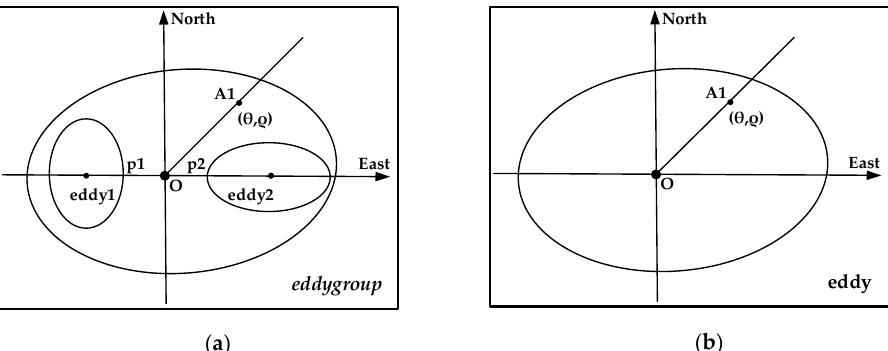
Figure 14. The spatial normalization of an eddygroup and eddy, where ( a , b ) are simplified representations of the eddygroup and eddy coordinate systems, respectively. In the eddygroup coordinate system ( a ), the x -axis is determined by the eddy cores of eddy1 and eddy2 and points eastward. The coordinate center O is the midpoint between p1 and p2, which are the intersections of the boundaries of eddy1 and eddy2 with the x -axis. In the eddy coordinate system ( b ), the coordinate center O is the eddy core and the positive direction of the y -axis points north. Any point A1 in the coordinate system used for normalization will be found in both the eddygroup and the eddy according to ( θ , ρ ) .